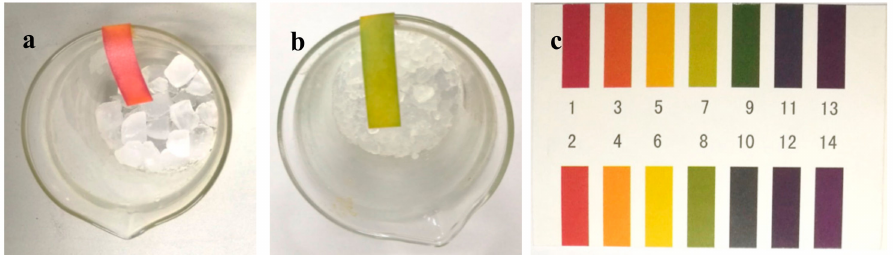
Figure 3. Nature of the vapors generated during the drying procedure of the samples. ( a ) sample 1; ( b ) sample 2; and ( c ) the standard colorimetric